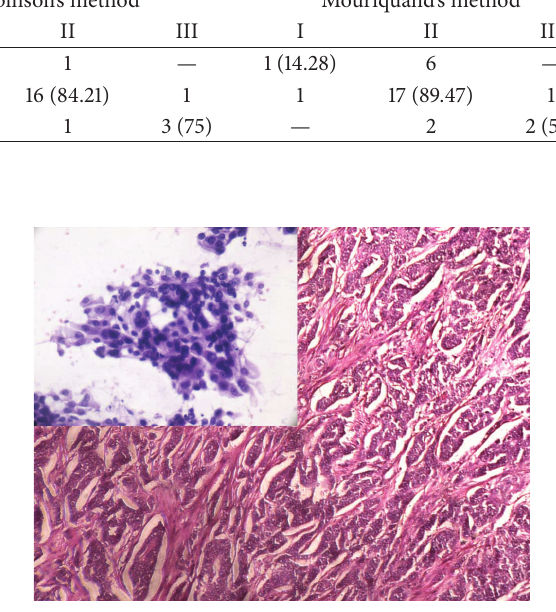
Figure 2: Infiltrating ductal carcinoma histological grade II— exhibiting cords and islands with tubular differentiation, mild variation in nuclear size and shape, vesicular nucleus, and con- spicuous nucleoli. Inset—less cohesive cluster of tumor cells with moderate pleomorphism, moderate nucleomegaly (3-4 times the size of erythrocytes), slight irregularity in nuclear envelope, and conspicuous nucleoli (Robinson’s cytological grade II) (H&E, × 100; inset: PAP, ×